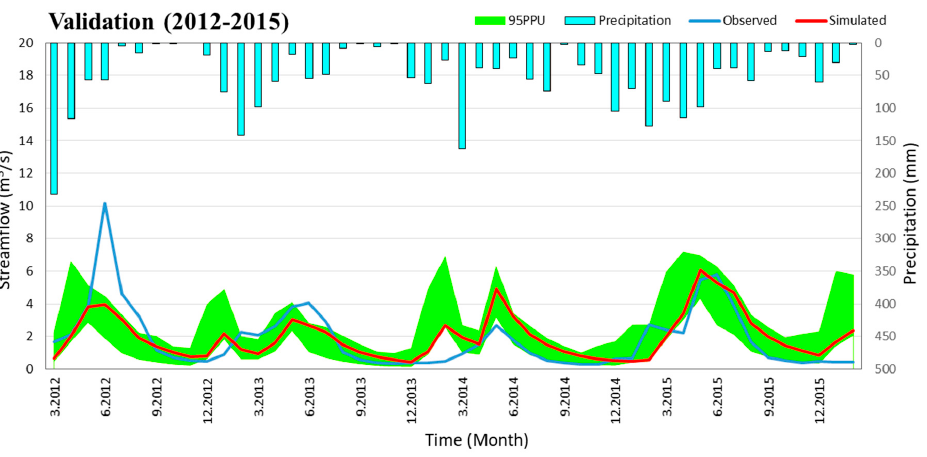
Figure 4. 95PPU graph for the validation stage.